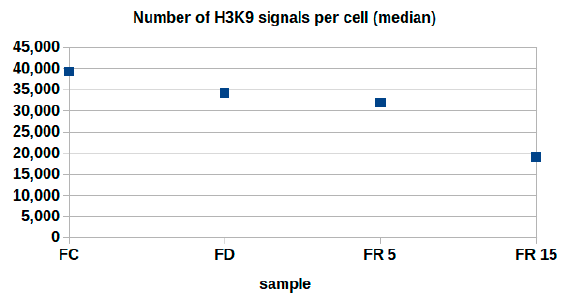
Figure 5. Median numbers of H3K9me3 signals for 4 different preparation conditions.